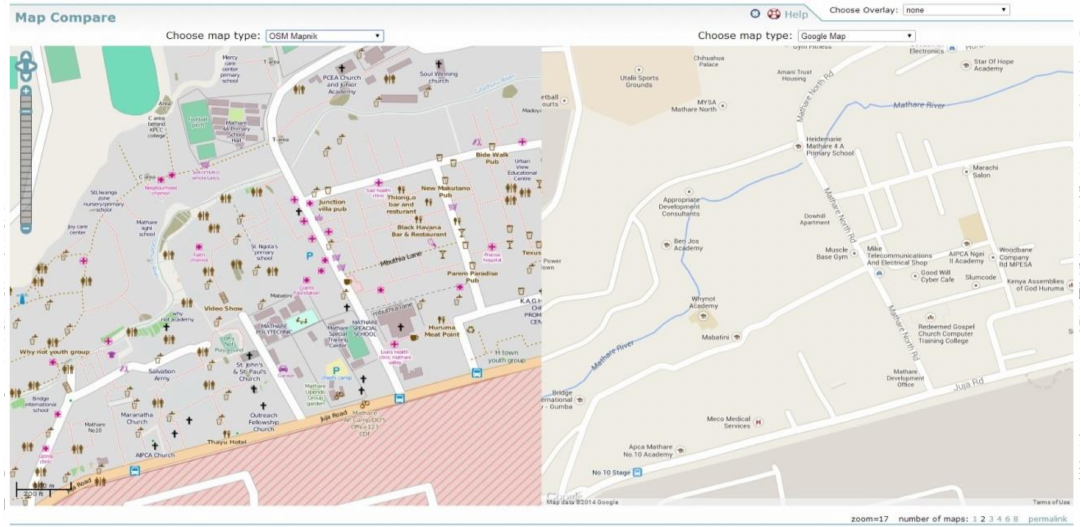
Figure 3. Part of the Mathare area on OpenStreetMap and Google Maps at scale